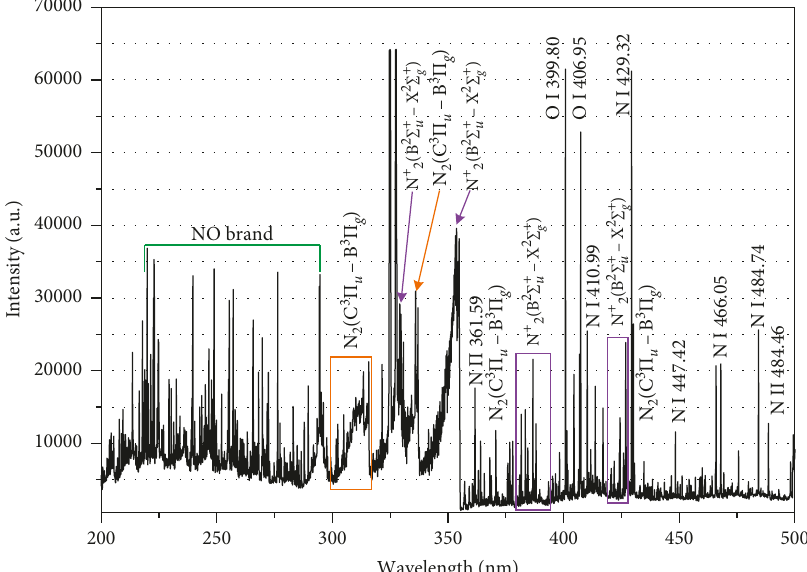
Figure 4: Emission spectra of N 2 plasma jet in the wavelength range of